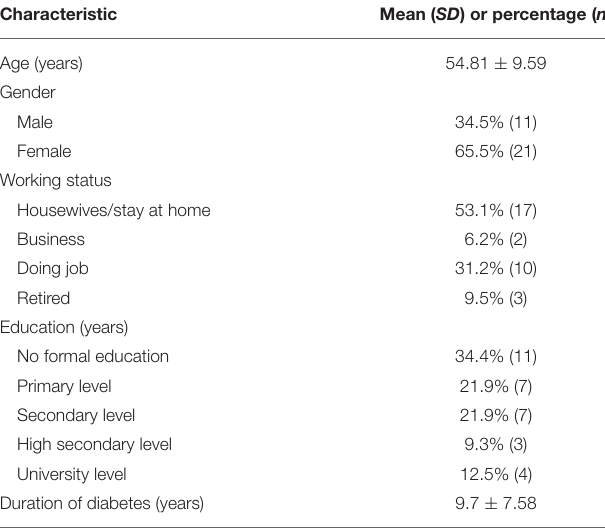
TABLE 1 | Demographic characteristics of the participants ( N =